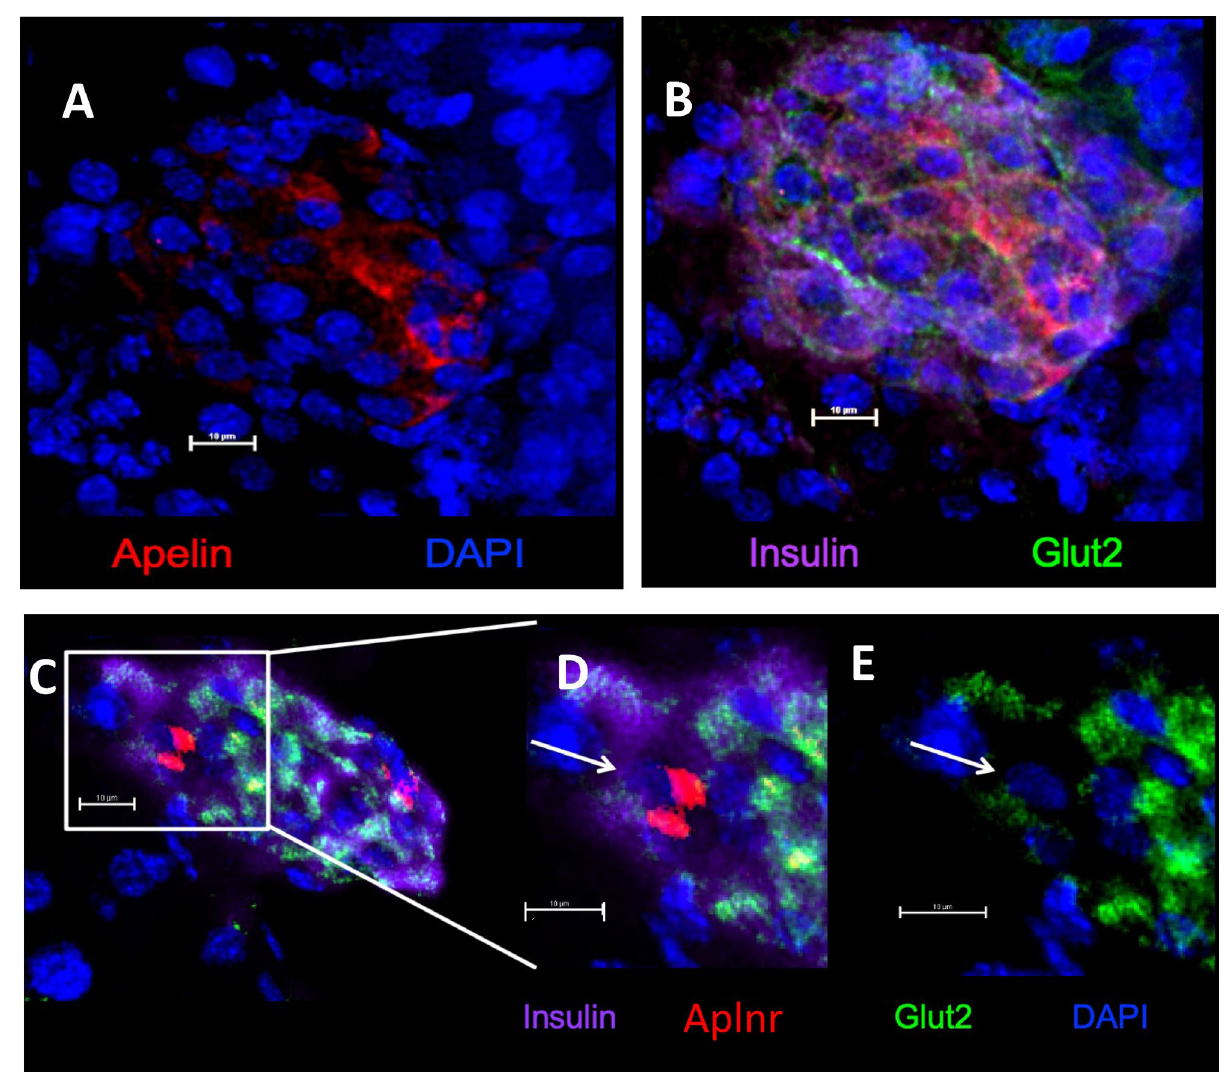
Figure 3. Immunohistochemical localization of Apelin alone ( A ), and in a merged image with insulin and Glut2 ( B ) in adult mouse pancreatic islets. Localization of insulin, Aplnr and Glut2 is shown in ( C ) with an expanded view of co-localization of Aplnr to Ins + Glut2 LO cells in ( D ) (arrows). The localization of Glut2 alone in the same section is shown in ( E ). Nuclei are counter-stained with DAPI (blue). Bar represents 10